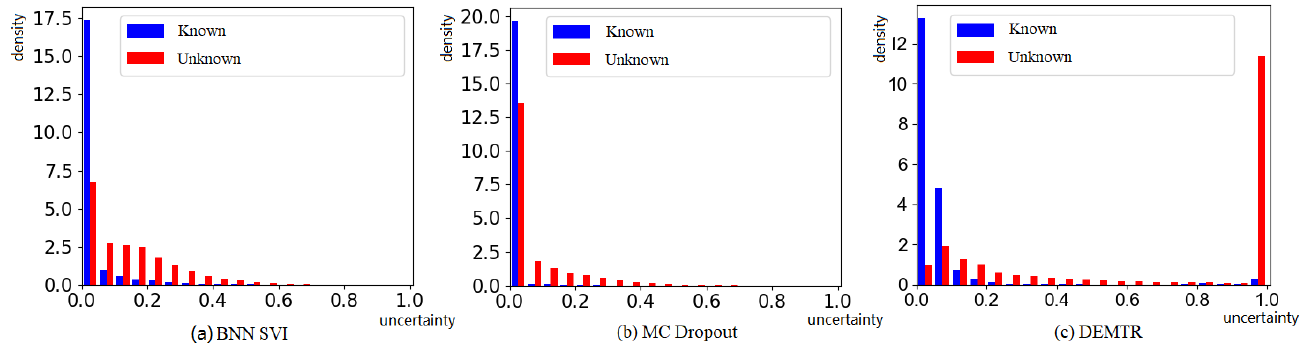
Figure 4. Histogram of uncertainty distribution for ( a ) BNN SVI, ( b ) MC Dropout and ( c ) the proposed DEMTR.